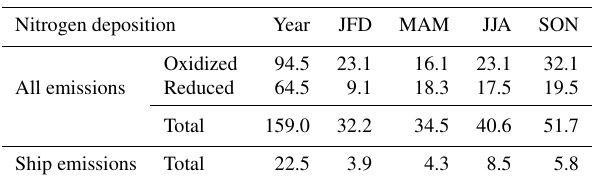
Table 3. Present-day annual and seasonal nitrogen deposition amounts (ktN) in the seawater of the Baltic Sea for 2012 and ship- related nitrogen deposition from the CD04 grid. Amounts refer to a Baltic Sea surface area of 431390km 2 including the western part of